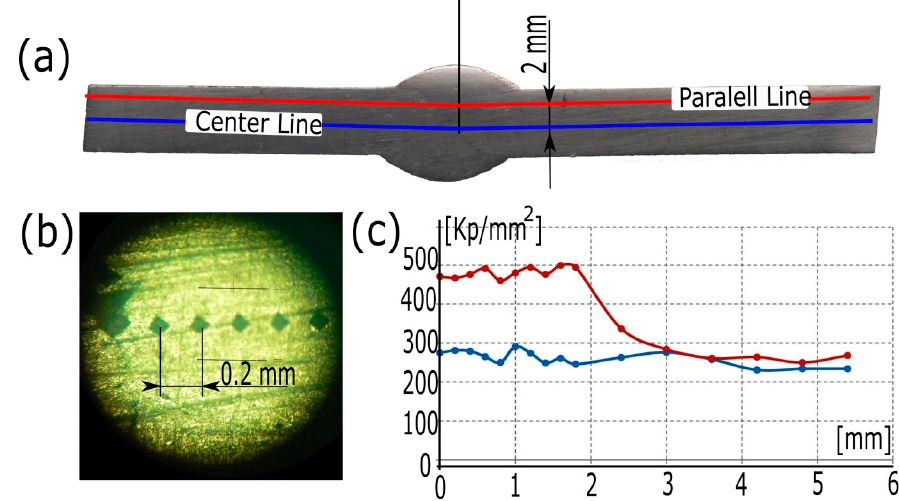
Figure 4. ( a ) Lines in which the hardness values in both the weld and the base metal were measured. ( b ) Micrograph that shows the hardness HV values obtained every 0.2 mm. ( c ) Varying hardness values obtained in both lines (centre line and parallel line).